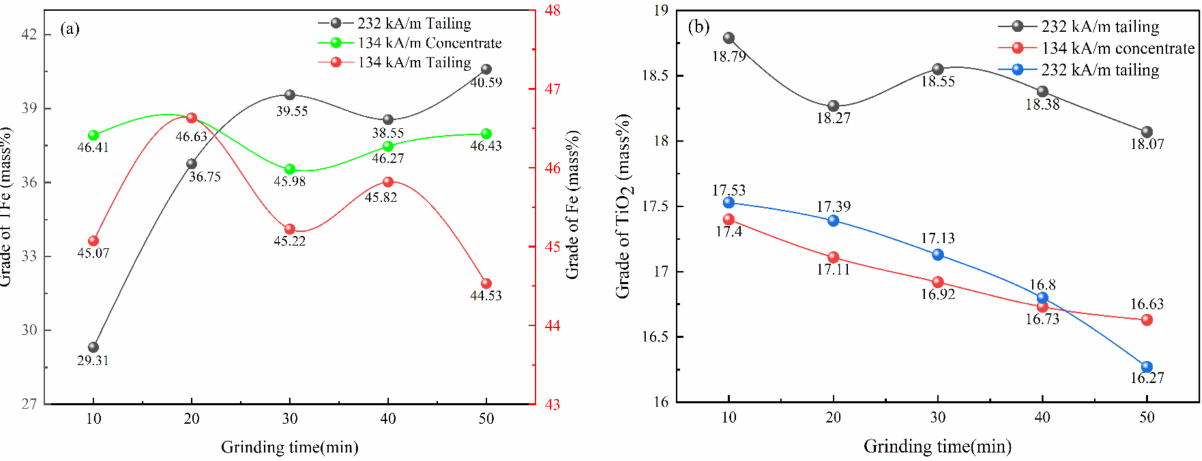
Figure 11. Effect of grinding time on the grade of ( a ) TFe and ( b ) TiO 2